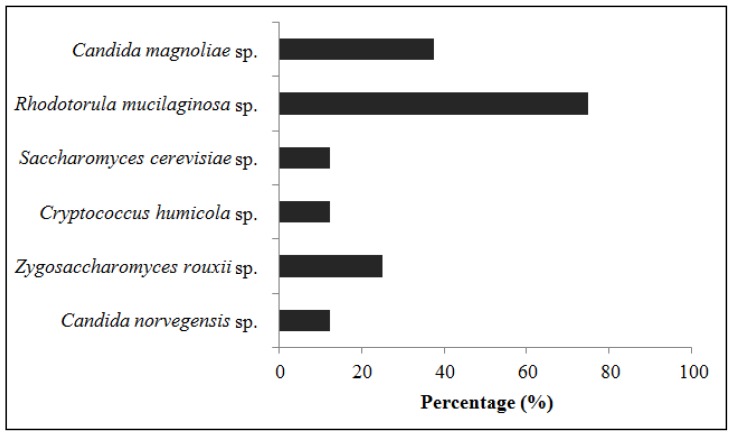
Percentage of the yeasts isolated from the samples.